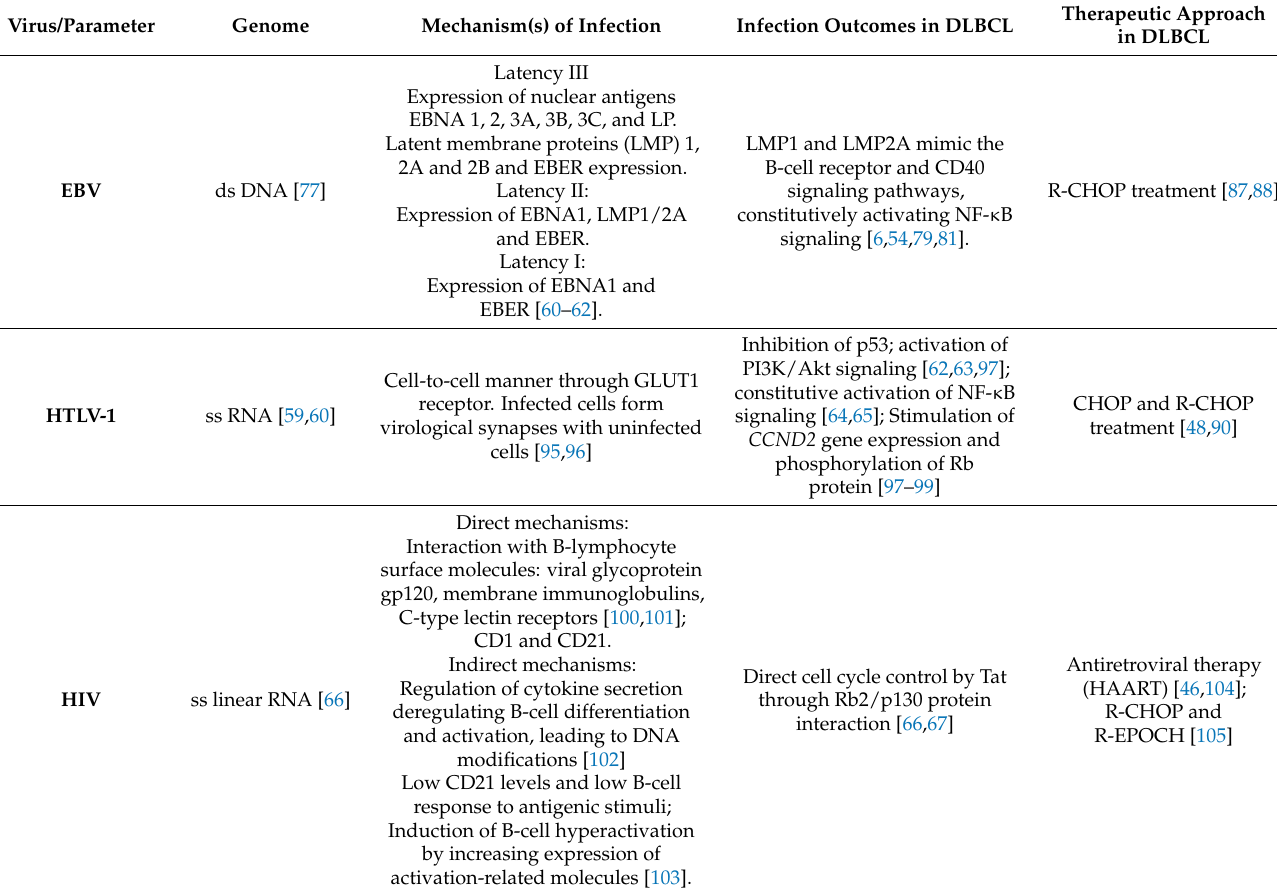
Table 1. Oncogenic viruses and their modes of action in DLBCL development. Virus/Parameter